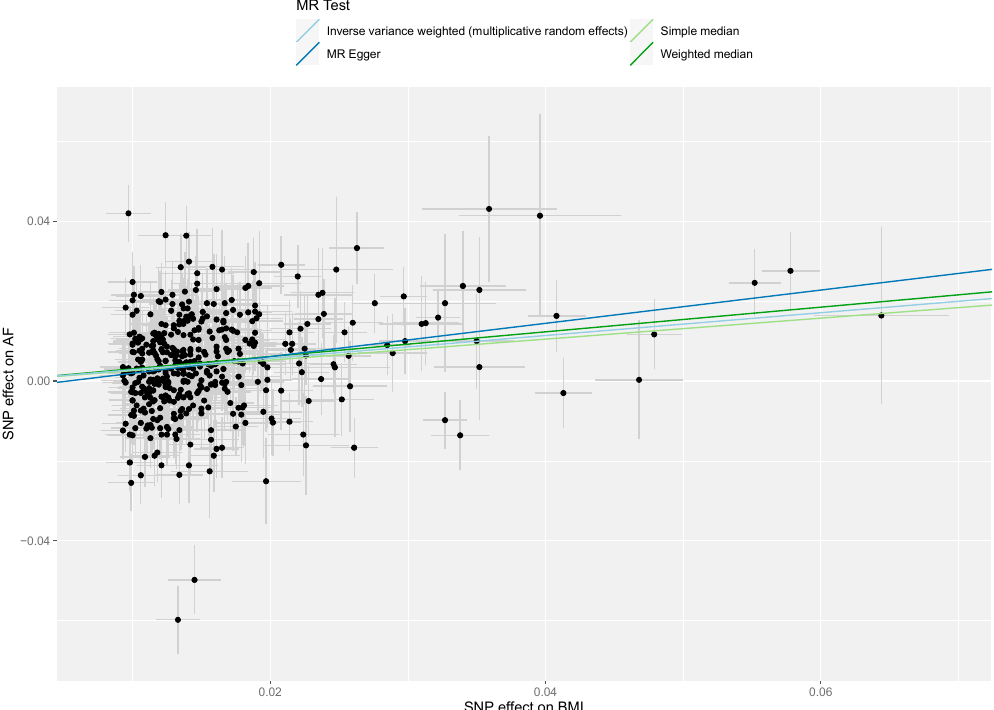
Figure 4. Mendelian randomisation (MR) scatter plot of genetic associations between body mass index (BMI) and atrial fibrillation (AF). The genetic association and corresponding 95% confidence interval (CI) for each instrumented single-nucleotide polymorphism ( n = 453) with BMI (x-axis, units of kg/m 2 ) and AF (y-axis, units of log odds ratio atrial fibrillation liability) are plotted. The gradient of each line represents the MR estimate for the corresponding model.